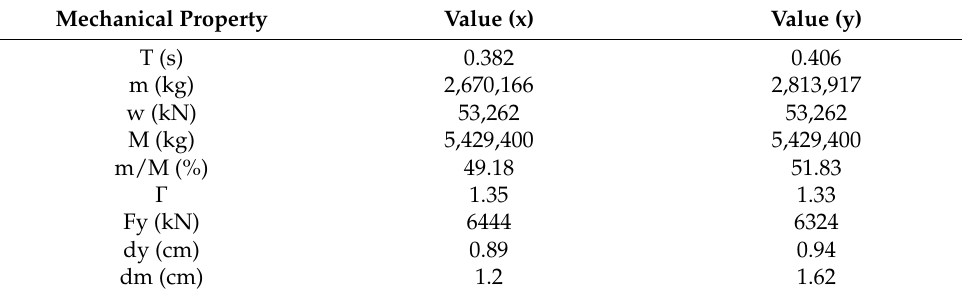
Table 2. SDOF parameters for pushover in x and y-direction.